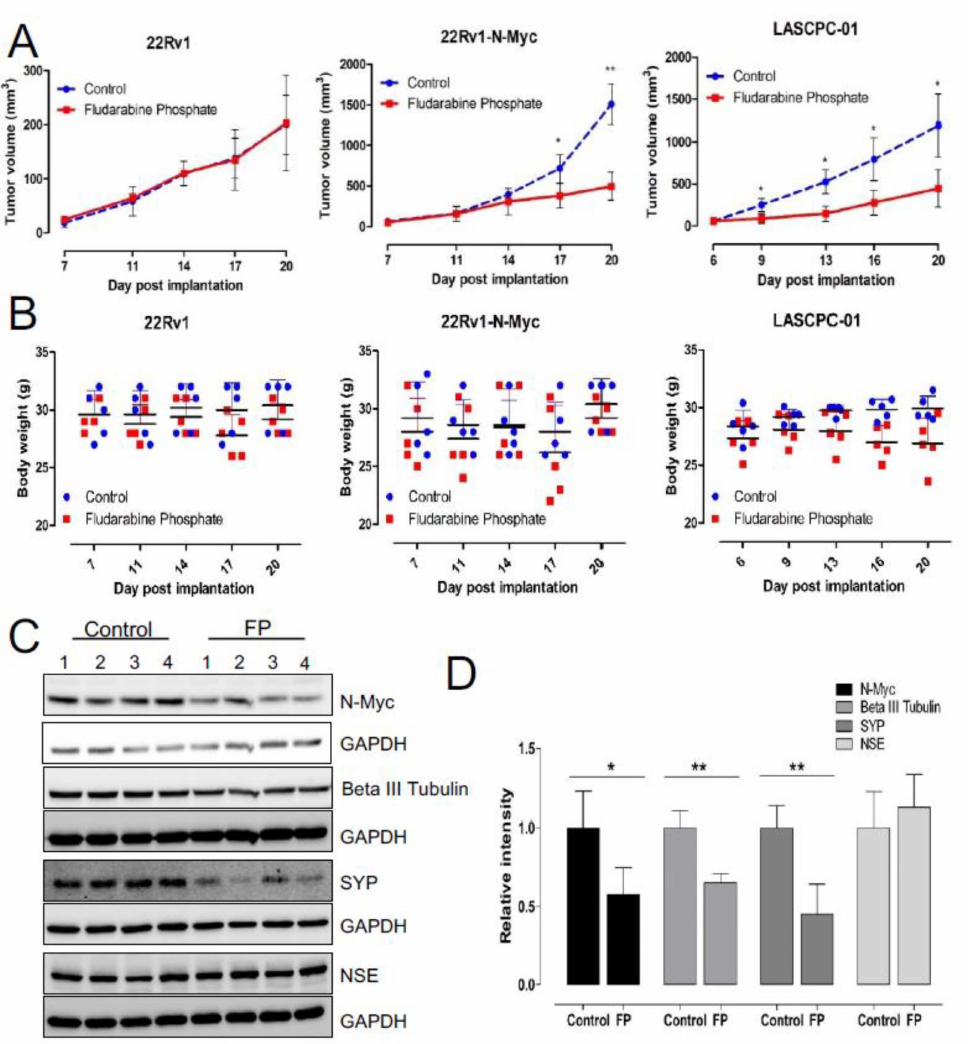
Figure 5. Fludarabine phosphate reduces tumor growth in NEPC xenograft models. ( A ) Validation of fludarabine phosphate treatment in 22Rv1, 22Rv1-N-Myc and LASCPC-01 xenograft models. Each cell line was implanted at 1 × 10 6 cells subcutaneously by injection in PBS: Matrigel mixture at the 1: 1 ratio of in a total volume of 100 µ L and monitored for tumor development. Fludarabine phosphate or DMSO was administered through i.p. injections at 120mg/kg starting day 6–7 post cell lines engraftment. Total of 10 i.p. injections were given per mouse (one i.p. injection per mouse per